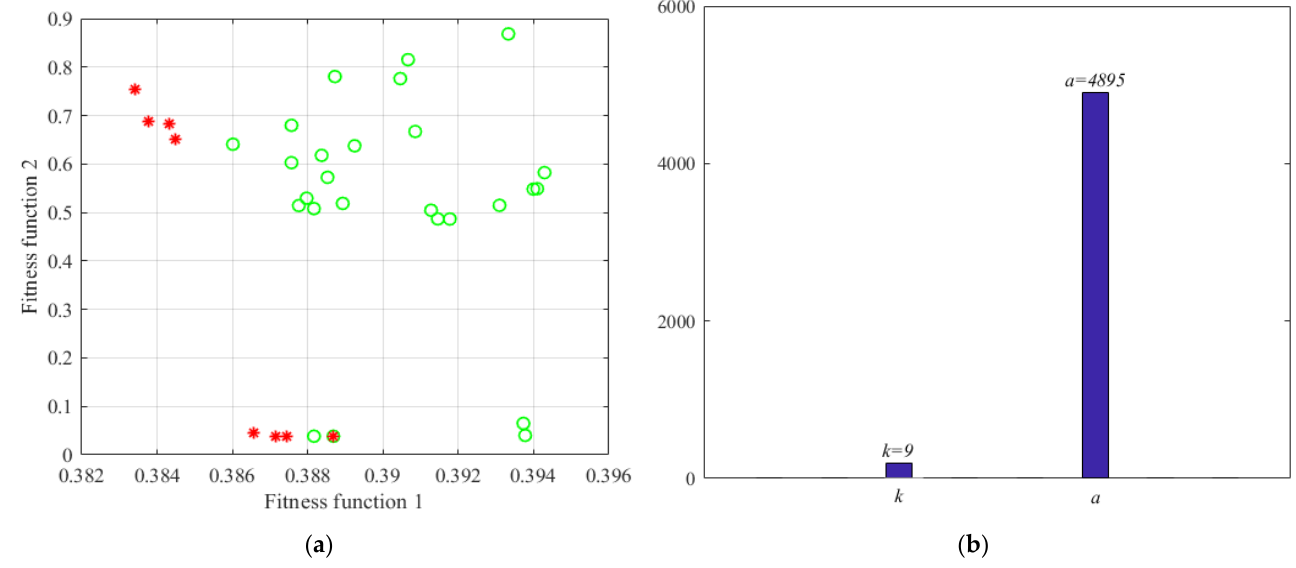
Figure 13. The optimization results of VMD, ( a ) is the particle distribution of the last iteration; ( b ) is the optimization result.